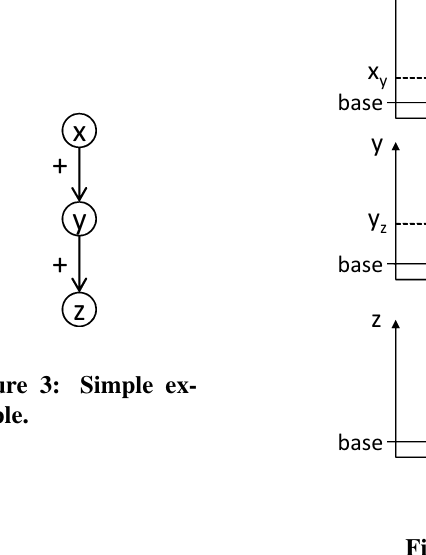
Figure 4: Change of concentrations with